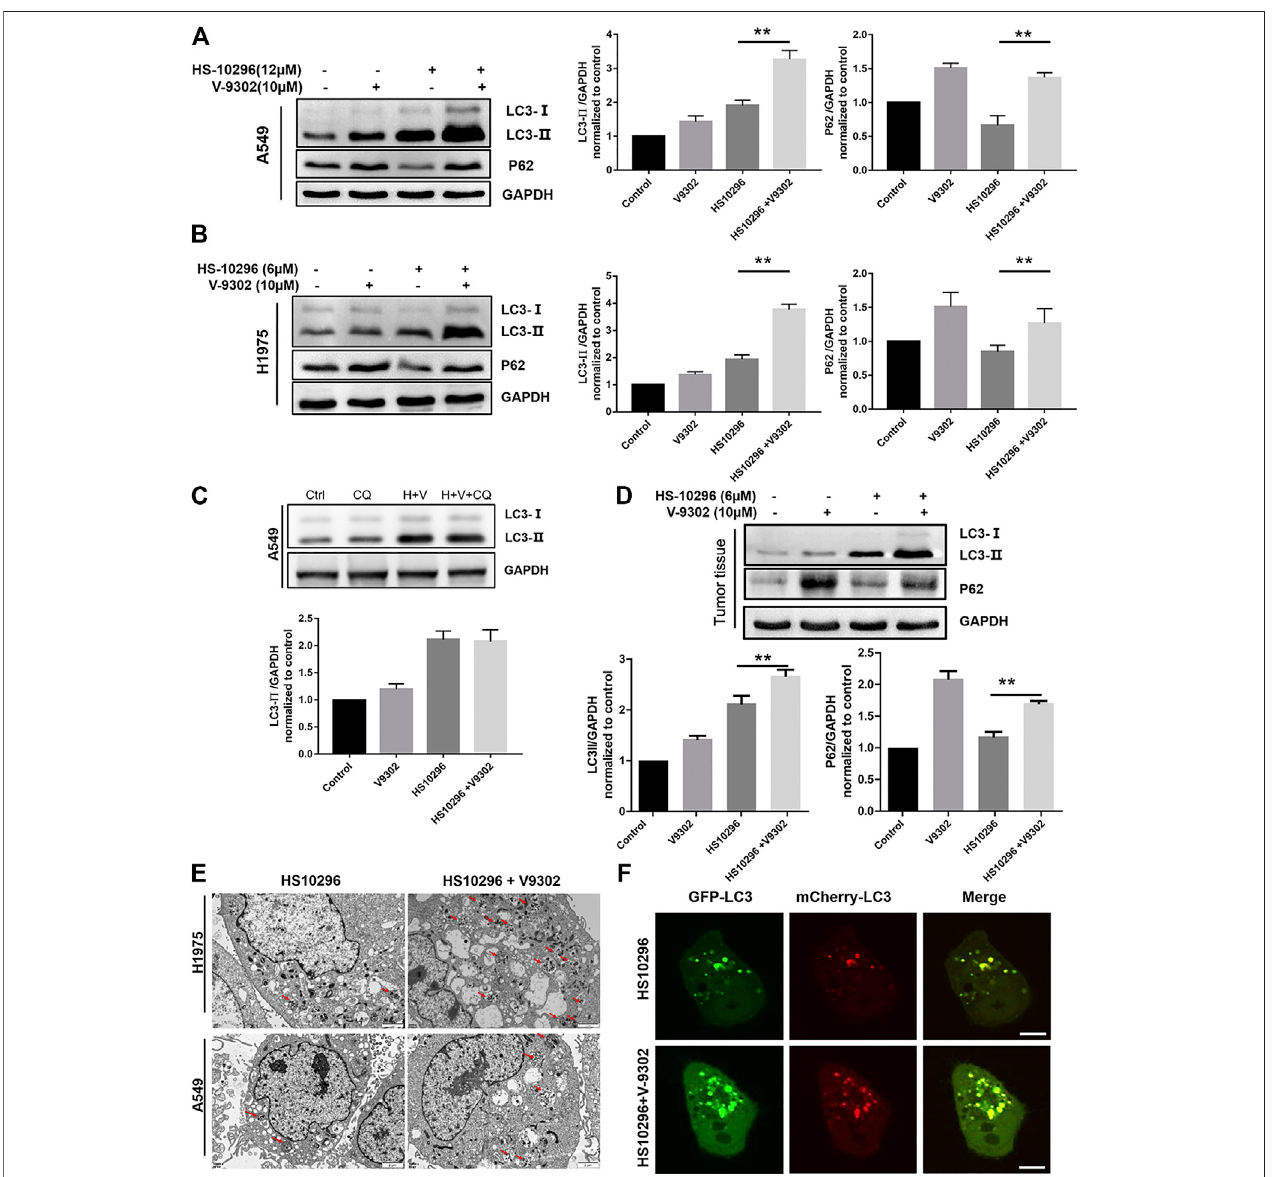
FIGURE 6 | Effect of V9302 on Almonertinib-induced autophagy. (A,B) Effect of different drug groups on protein expression of autophagy marker protein LC3-II andP62incelllinesbyWB. (C) AlmonertinibaloneorcombinedwithchloroquinetoobservetheeffectontheproteinlevelofLC3-II. (D) .Effectofdifferentdruggroupson protein expression of autophagy marker protein LC3-II and P62 in tumor tissues. (E) A549 (H1975) cells were treated with 12 μ M (6 μ M) Almonertinib alone or in combinationwith10 μ MV9302for12 h,then fi xedandobservedwithanelectronmicroscope. (F) mCherry-GFP-LC3Bwasusedtodetecttheautophagy fl uxlevel of Almonertinib combined with V9302 in H1975 cells for 12 h. Signi fi cance: * p < 0.05, ** p < 0.01.